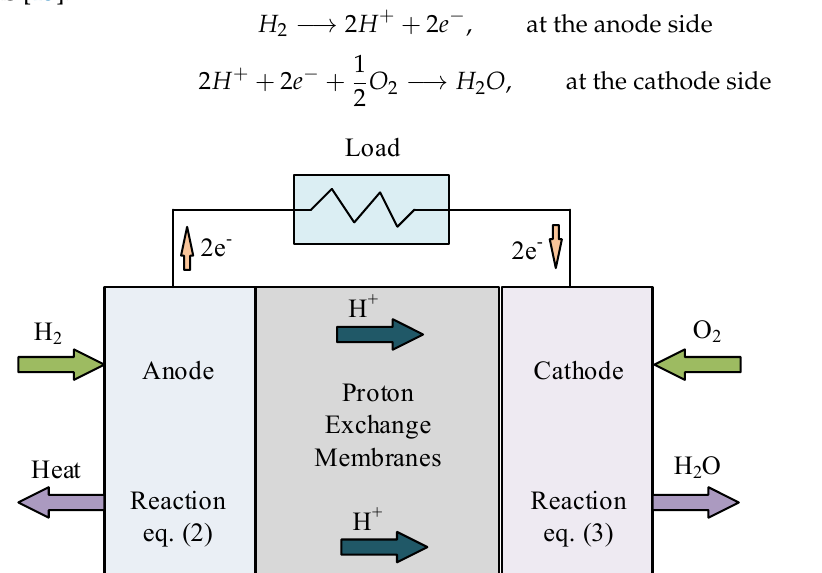
Figure 3. The main structure of